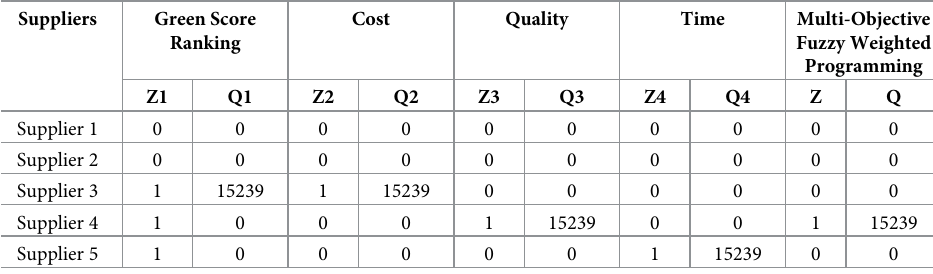
Table 19. Qualified supplier(s) after sensitivity analysis.